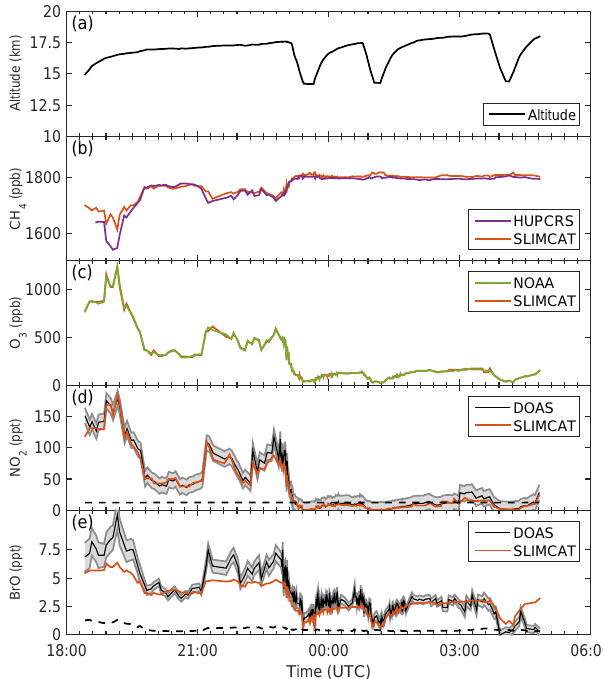
Figure 12. Panel (a) shows the time–altitude trajectory of the sun- lit part of SF3-2013 (14/15 February 2013). Intercomparison of measured and Tomcat/Slimcat-simulated CH 4 (HUPCRS) (b) , O 3 (NOAA) (c) , NO 2 (mini-DOAS) (d) and BrO (mini-DOAS) (e) . The errors of the mini-DOAS NO 2 , and BrO, shown as gray areas in panels (d) and (e) , include all dominating errors, i.e., the spectral retrieval error, the overhead, and the error due to a tropospheric con- tribution to the slant absorption. The dashed lines in panels (d) and (e) represent the detection limits of the mini-DOAS observations.